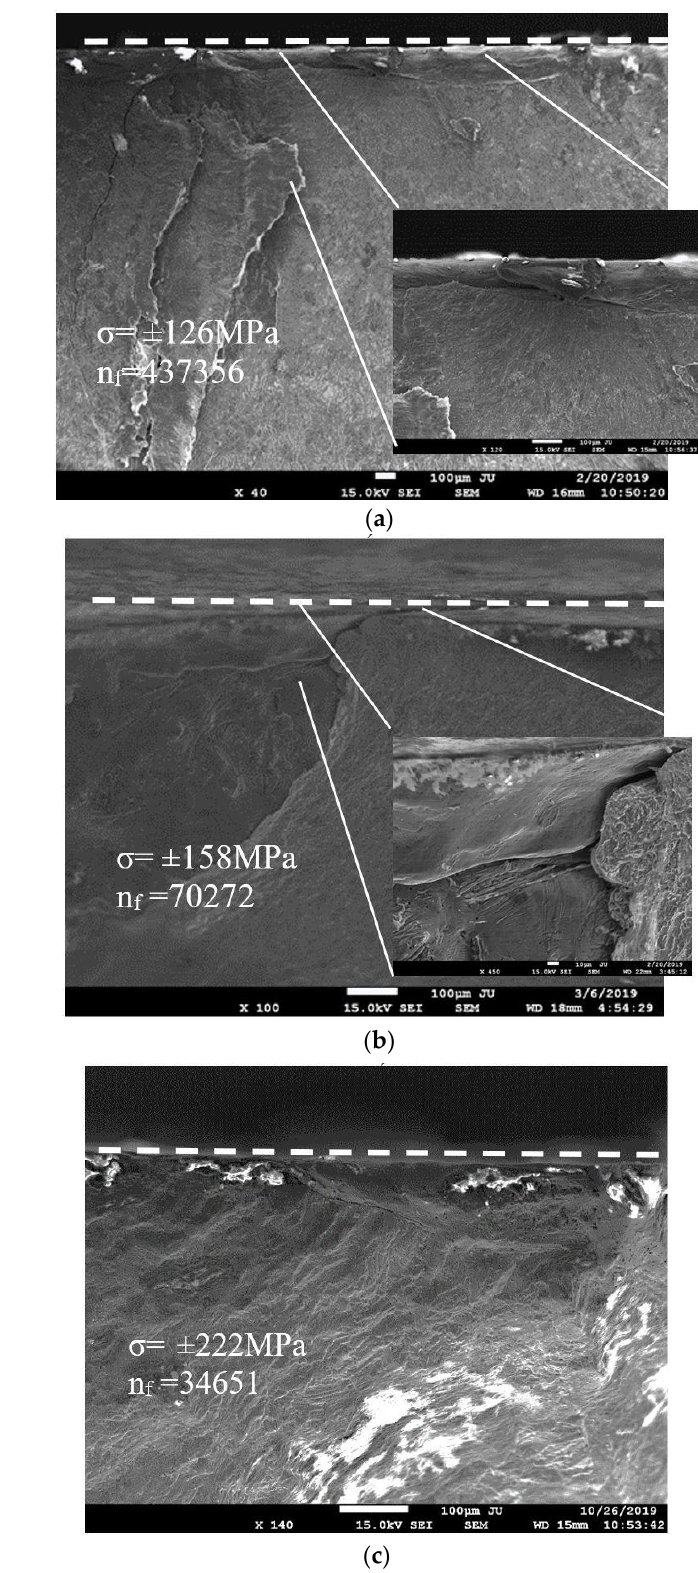
Figure 7. T-SEM micrographs showing the fracture surface of the ( a ) SSM Al – 7Si – 0.45Mg casting in the T5 condition, ( b ) SSM Al – 7Si – 0.6Mg casting in the T5, and ( c ) SSM Al – 7Si – 0.3Mg casting in the T6 conditions. The dashed line shows the casting surface position in the image.